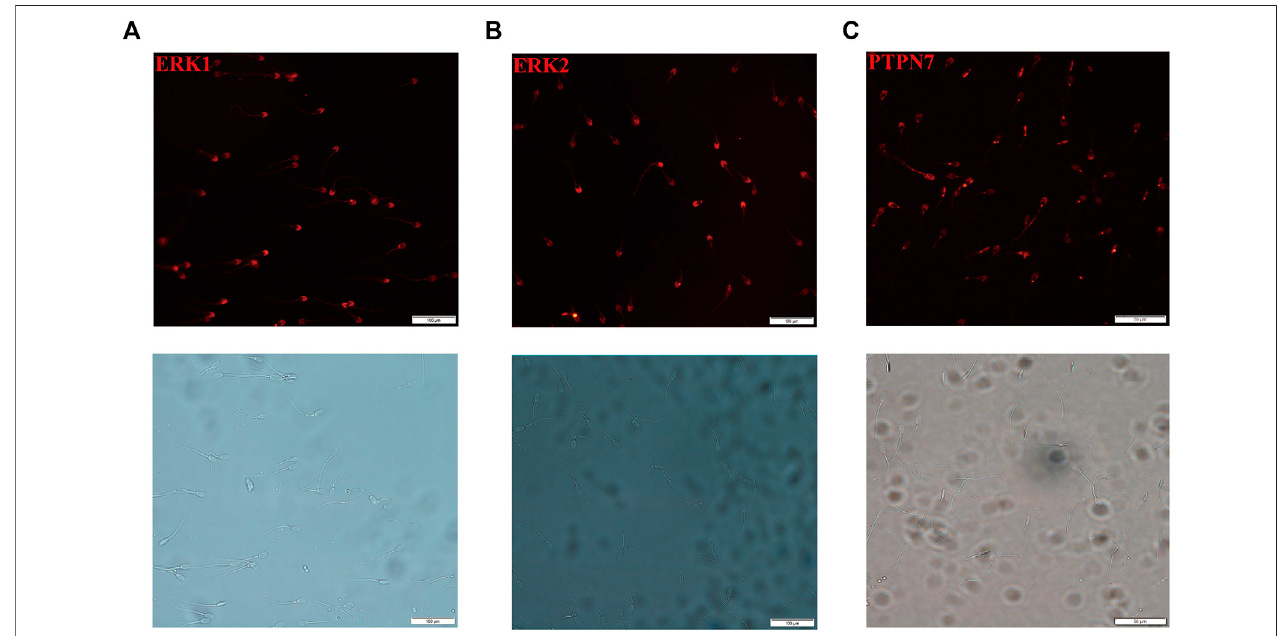
FIGURE 6 | Localization of ERK1/2 and PTPN7 on boar sperm. (A) ERK1, (B) ERK2, and (C) PTPN7.